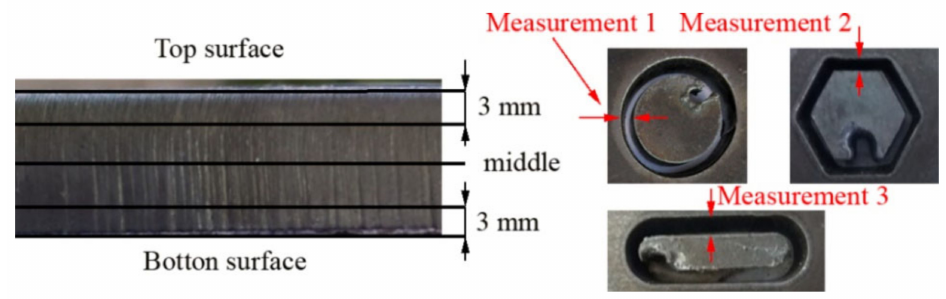
Figure 3. Example of three positions for measurement surface roughness and kerf width for thickness of 10 mm (PAM).